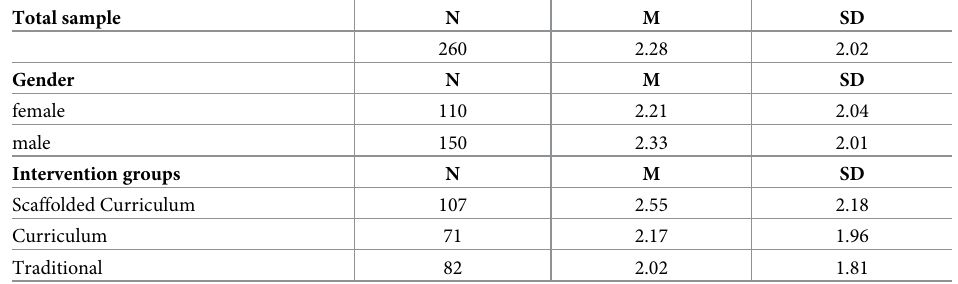
Table 2. Pretest outcomes for the total sample, female and male students, as well as students from the three groups. Total sample